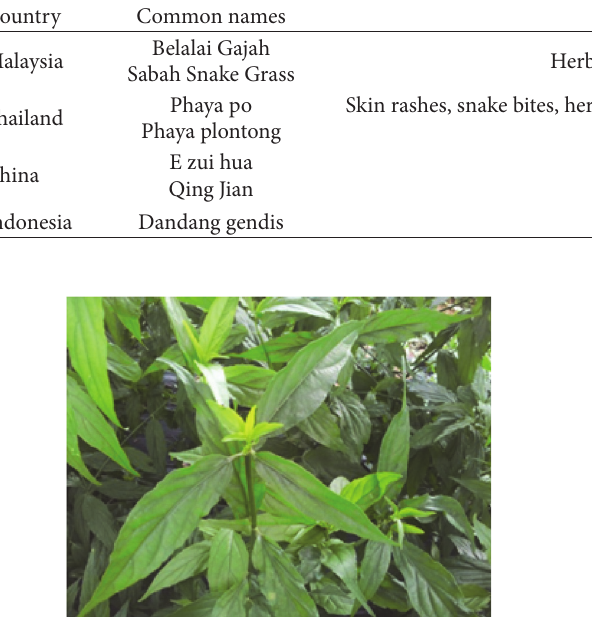
Figure 1: Fresh leaves of Clinacanthus nutans